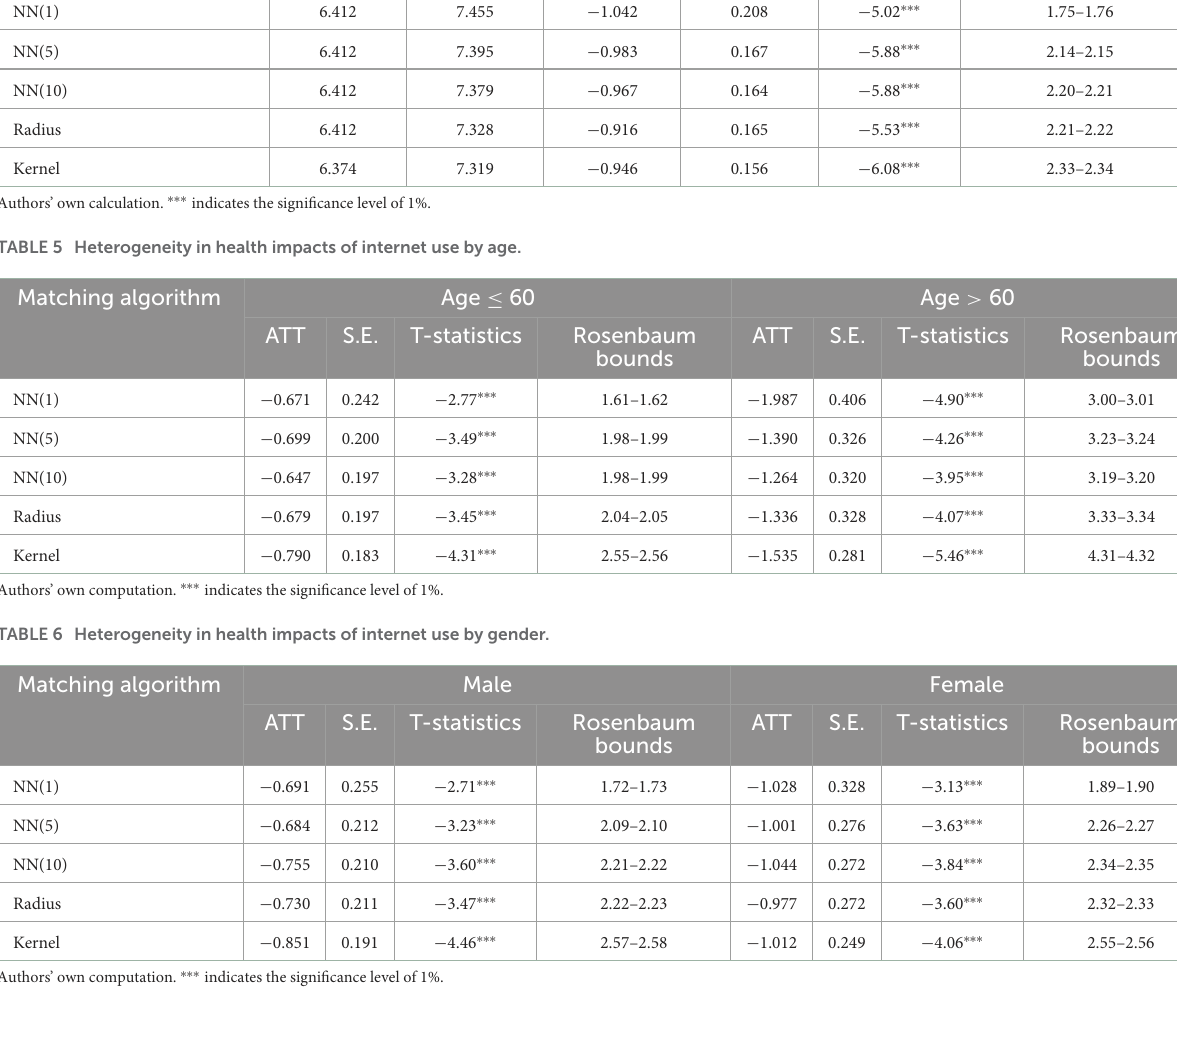
TABLE 4 The effect of internet use on depression from propensity score matching (PSM). Matching algorithm